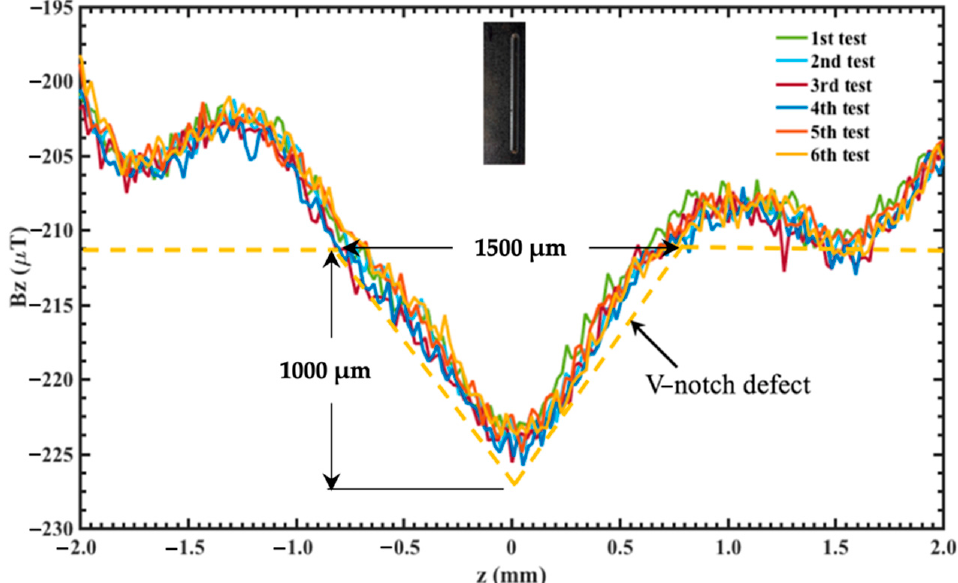
Figure 5. Variation of tangential MMM signals measured around the second V-shaped notch (1500 µm width and 1000 µm depth) of the ASTM-A36 steel pipe, which were measured using six experimental tests.